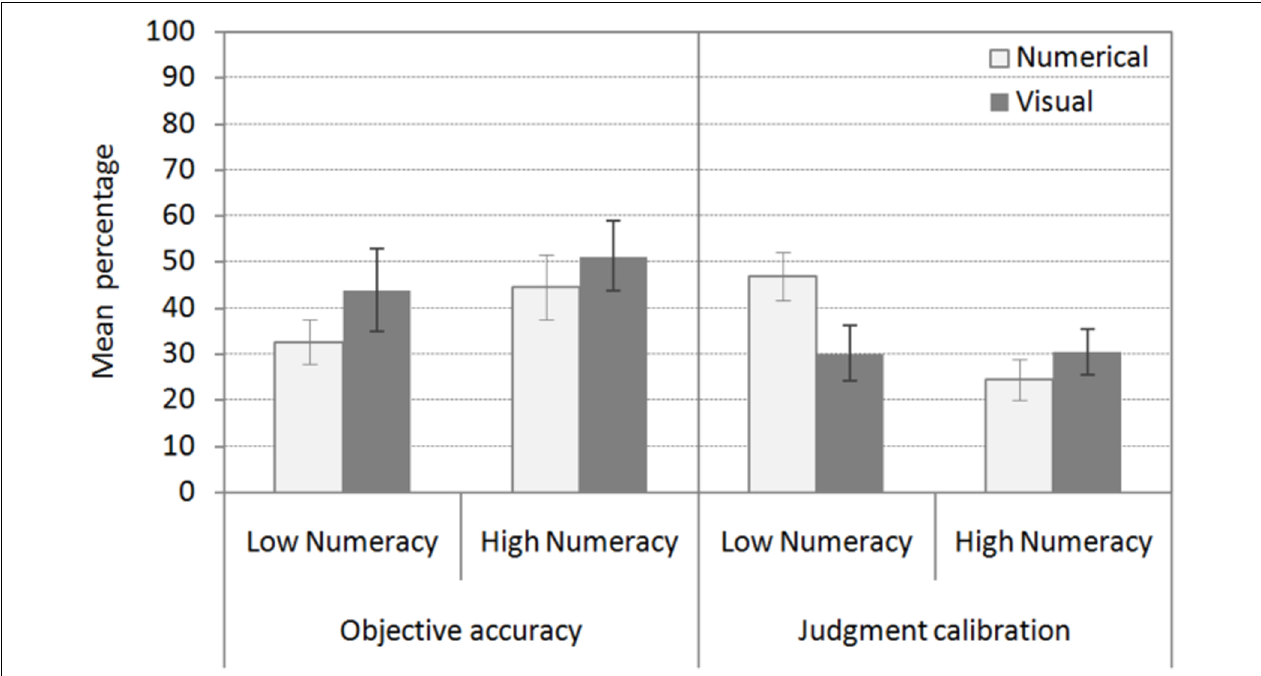
FIGURE 4 | Objective accuracy across the three diagnostic tasks by information format and numeracy after controlling for the effect of metacognitive judgment calibration. Metacognitive judgment calibration